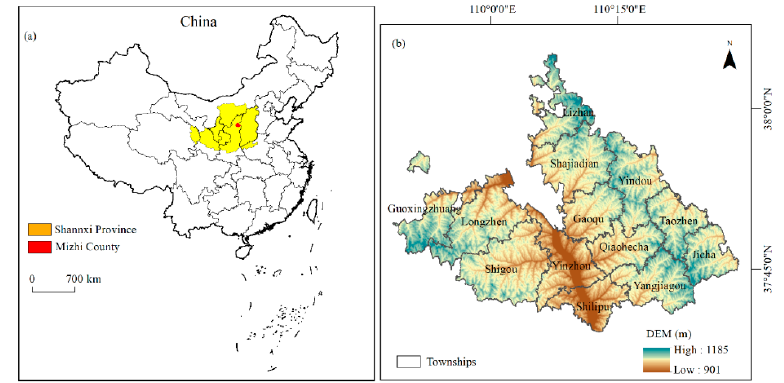
Figure 1. Location and DEM (Digital Elevation Model) of Mizhi County, Shaanxi Province, China.